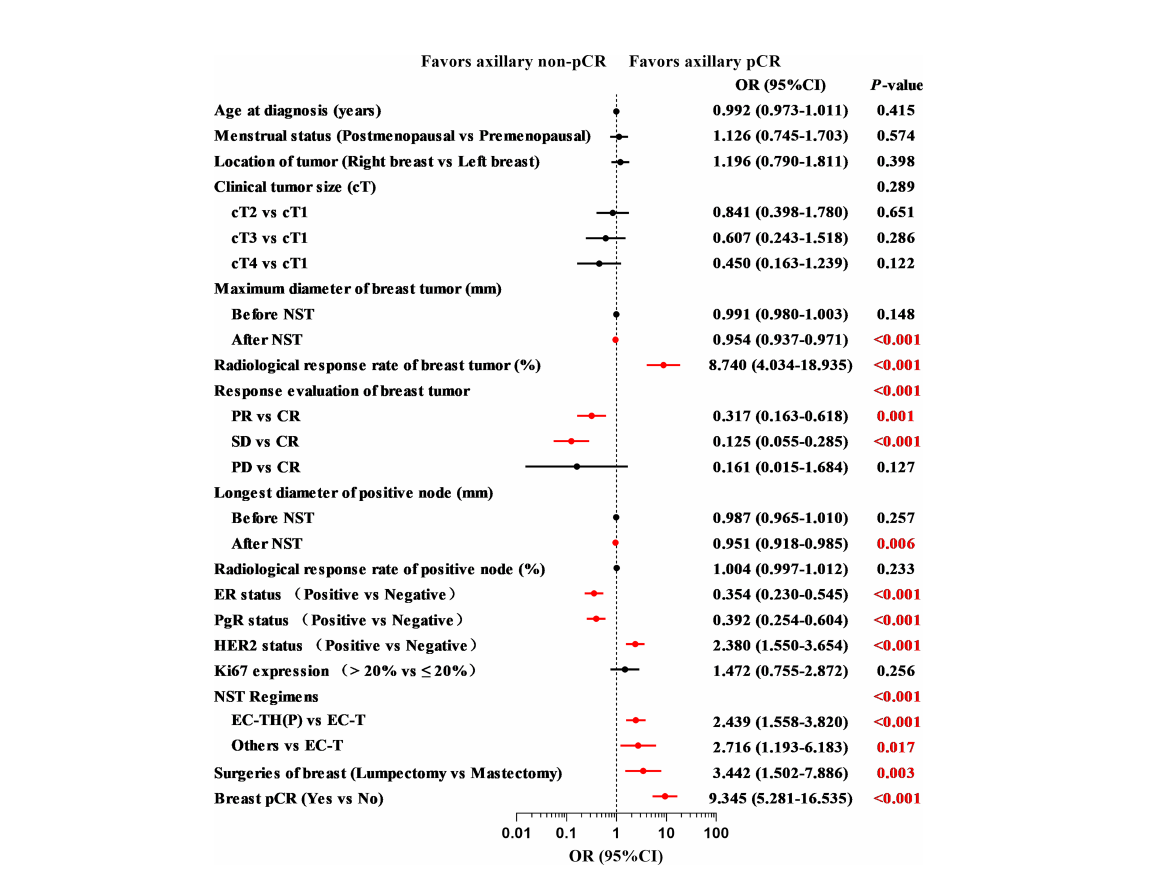
FIGURE 3 The results of univariate logistic regression analysis of indicators associated with axillary pCR in the training set (N = 378) pCR, pathologic complete response; NST, neoadjuvant systemic therapy; CR, complete response; PR, partial response; SD, stable disease; PD, progressive disease; ER, estrogen receptor; PgR, progesterone receptor; HER2, human epidermal growth factor receptor 2; EC-TH(P), epirubicin, cyclophosphamide followed by taxanes, trastuzumab and